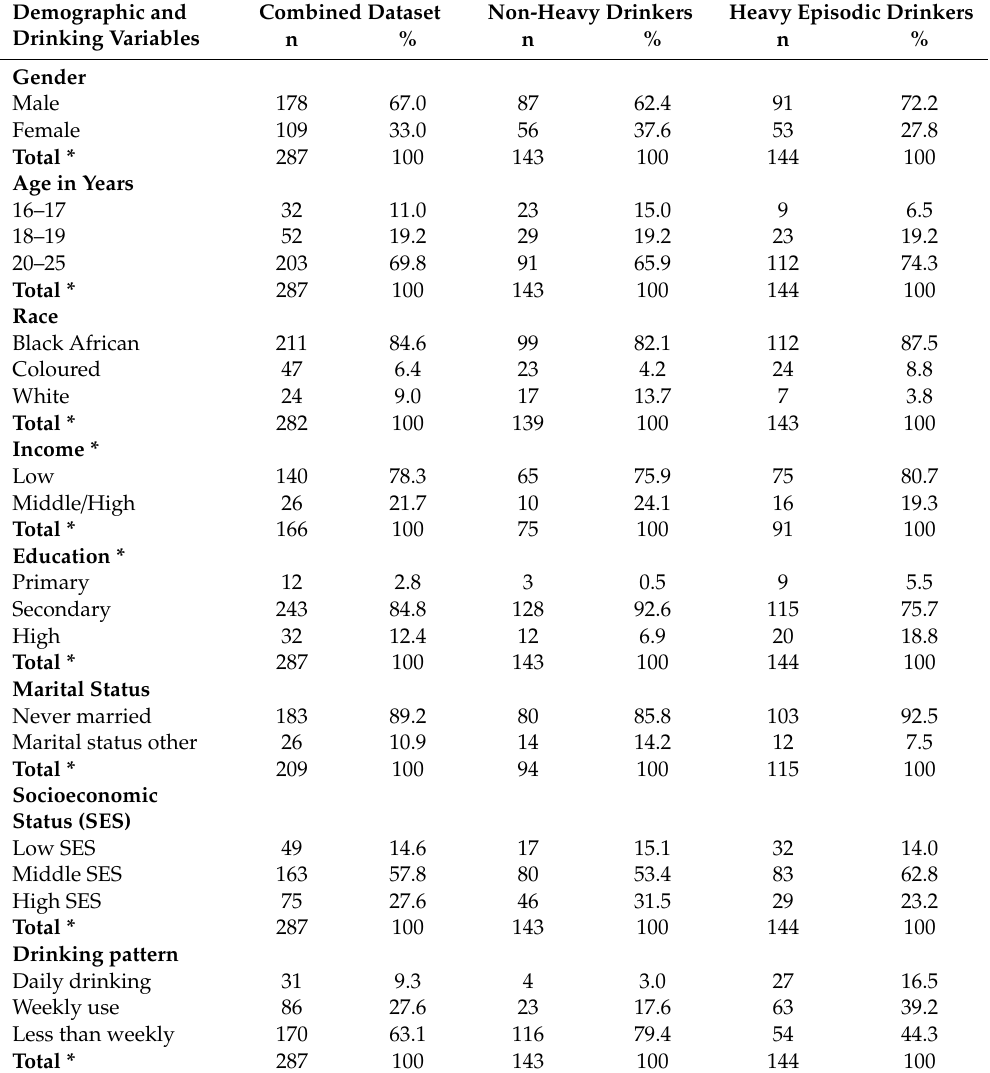
Table 1. Survey participant demographic details (n =